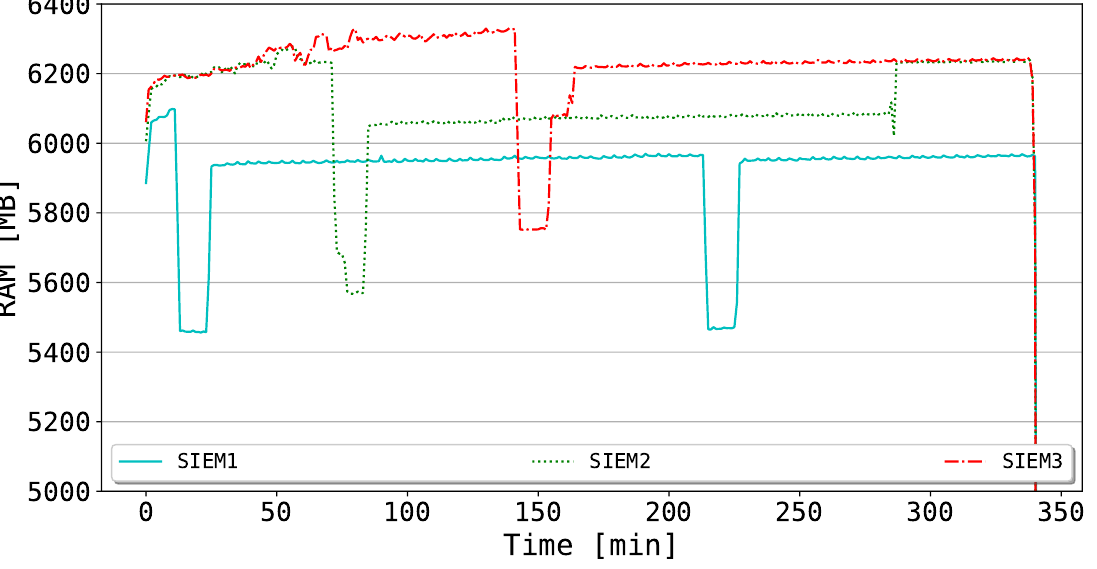
Figure 9. RAM utilization for the different SIEMs during drops and successive